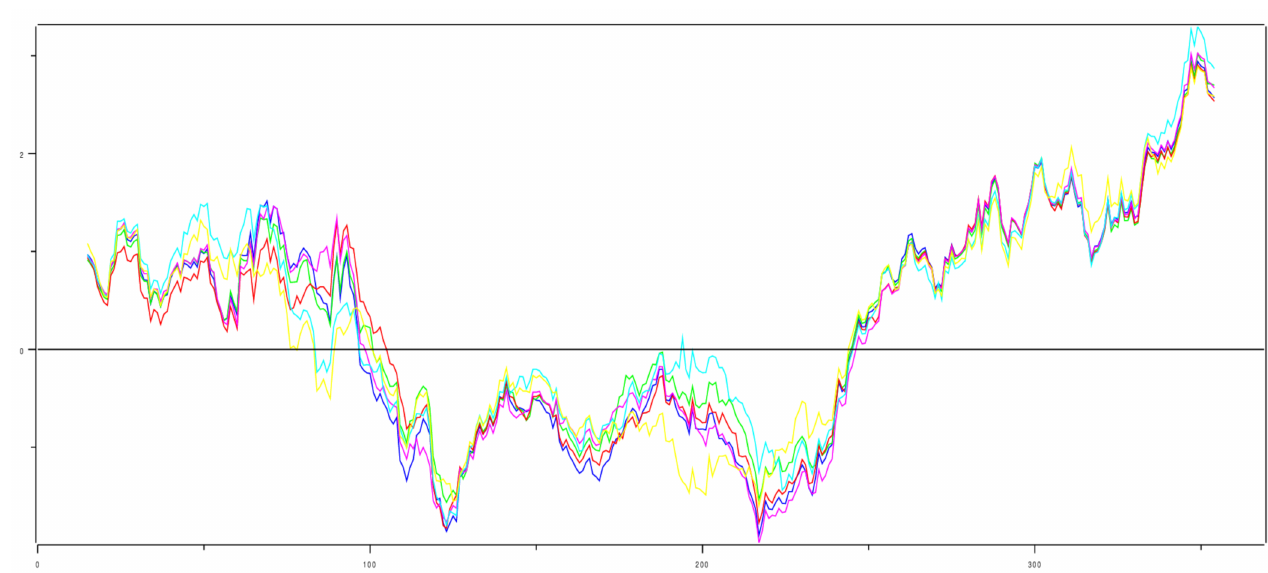
Figure 2. Results of ProSa for selected